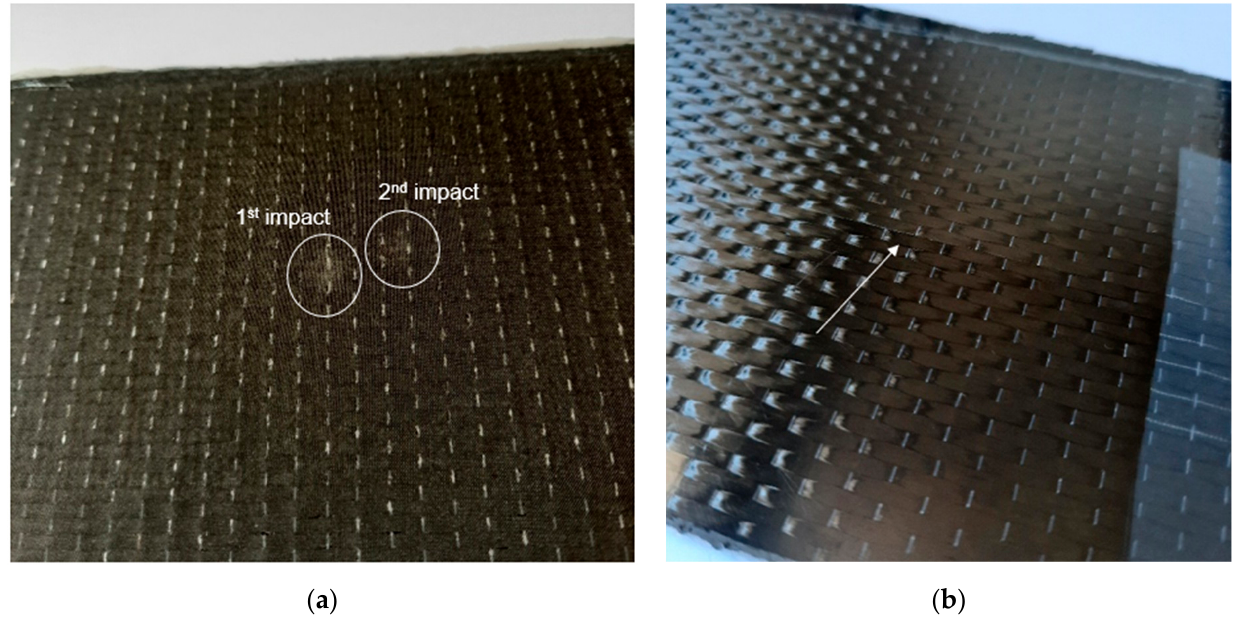
Figure 6. Example of ( a ) indentation marks on the top surface resulting from the first and second impact events, and of ( b ) small bump on the bottom surface.